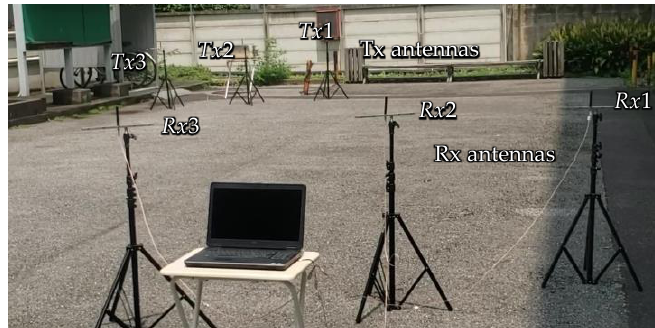
Figure 8. Photo of the experimental environment.